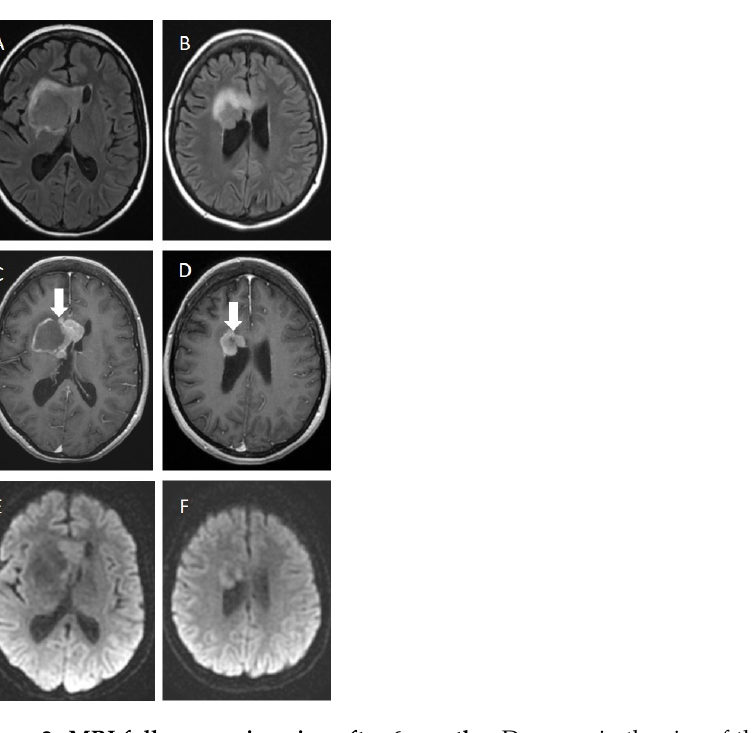
Figure 2. MRI follow—up imaging after 6 months. Decrease in the size of the large lesion ( C,D ) (arrow), significant reduction in vasogenic edema ( A,B ), restricted diffusion ( E , F ) and no signs of lesions in both parietal lobes and left caudate nucleus.